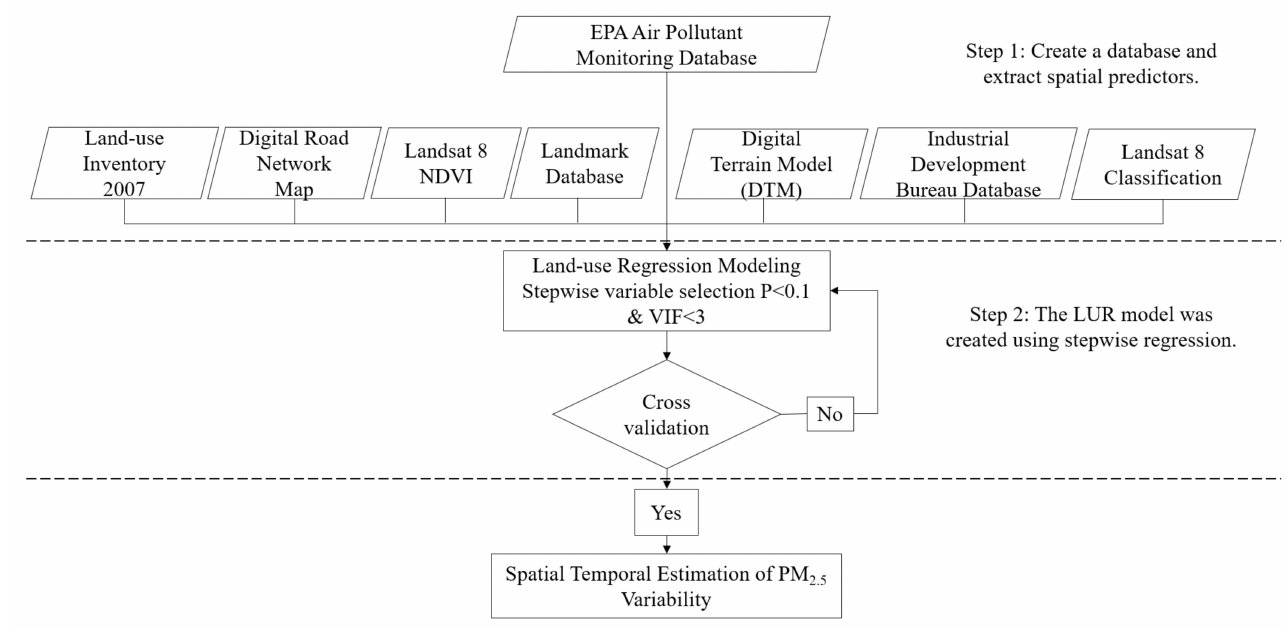
Figure 4. Framework of model development and evaluation for PM 2.5 concentration